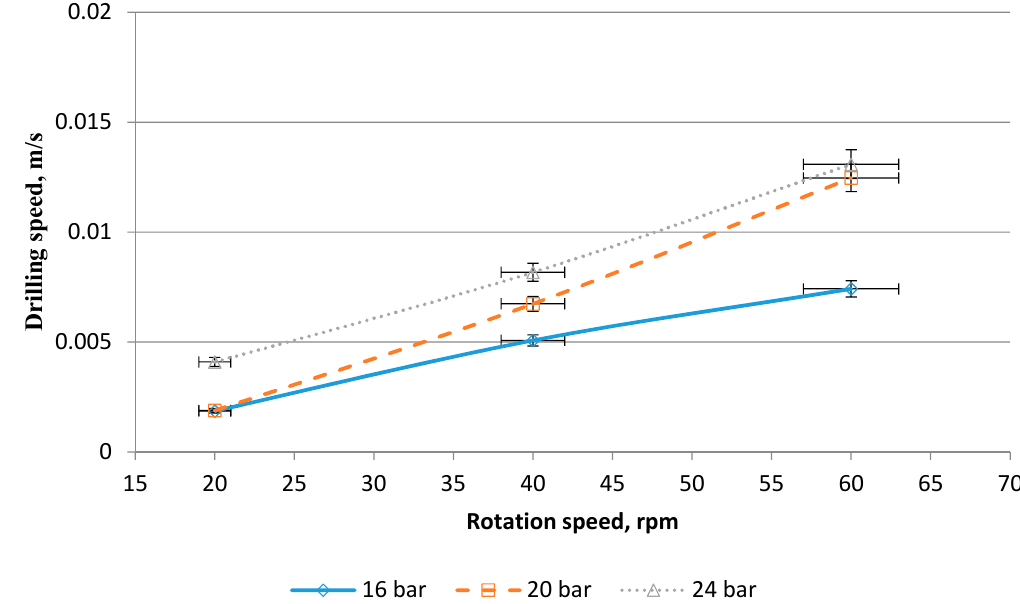
Figure 12. Variation of drilling velocity with rotation speed for several pressures (shown in the legend below the figure), for the 140 mm diameter drill bit, an interval of 72 to 90 m below the ground level, and boreholes 7–9.